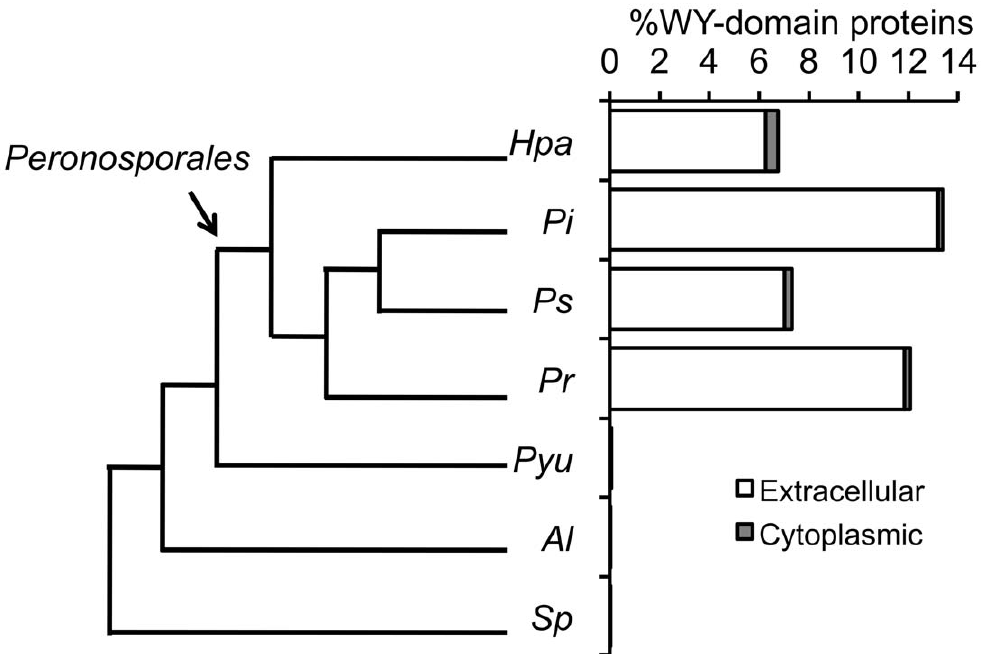
Figure 2. Phylogenetic relationship and presence of the WY-domain HMM signature in sequenced oomycete genomes. Schematic representation of the phylogenetic relationship among seven oomycetes for which genome sequences are available and the distribution of WY- domain in their extracellular and cytoplasmic proteomes (as a percentage of the total). Hpa = H. arabidopsidis ; Pi = P. infestans ; Ps = P. sojae ; Pr = P. ramorum ; Pyu=P. ultimum ; Al = A. labachii ; Sp = S. parasitica